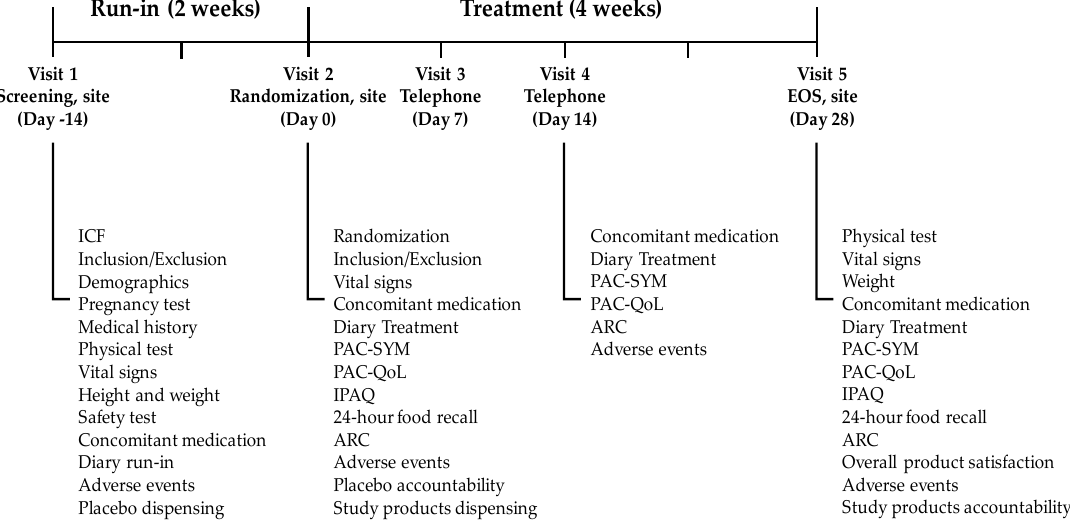
Figure 1. Study outline. There were 5 study visits during the entire study. EOS-End of Study; ICF-informed consent form; PAC-SYM-patient assessment of constipation symptoms; PAC-QoL-patient assessment of constipation quality of life; IPAQ-international physical activity questionnaire; ARC-adequate relief of constipation.